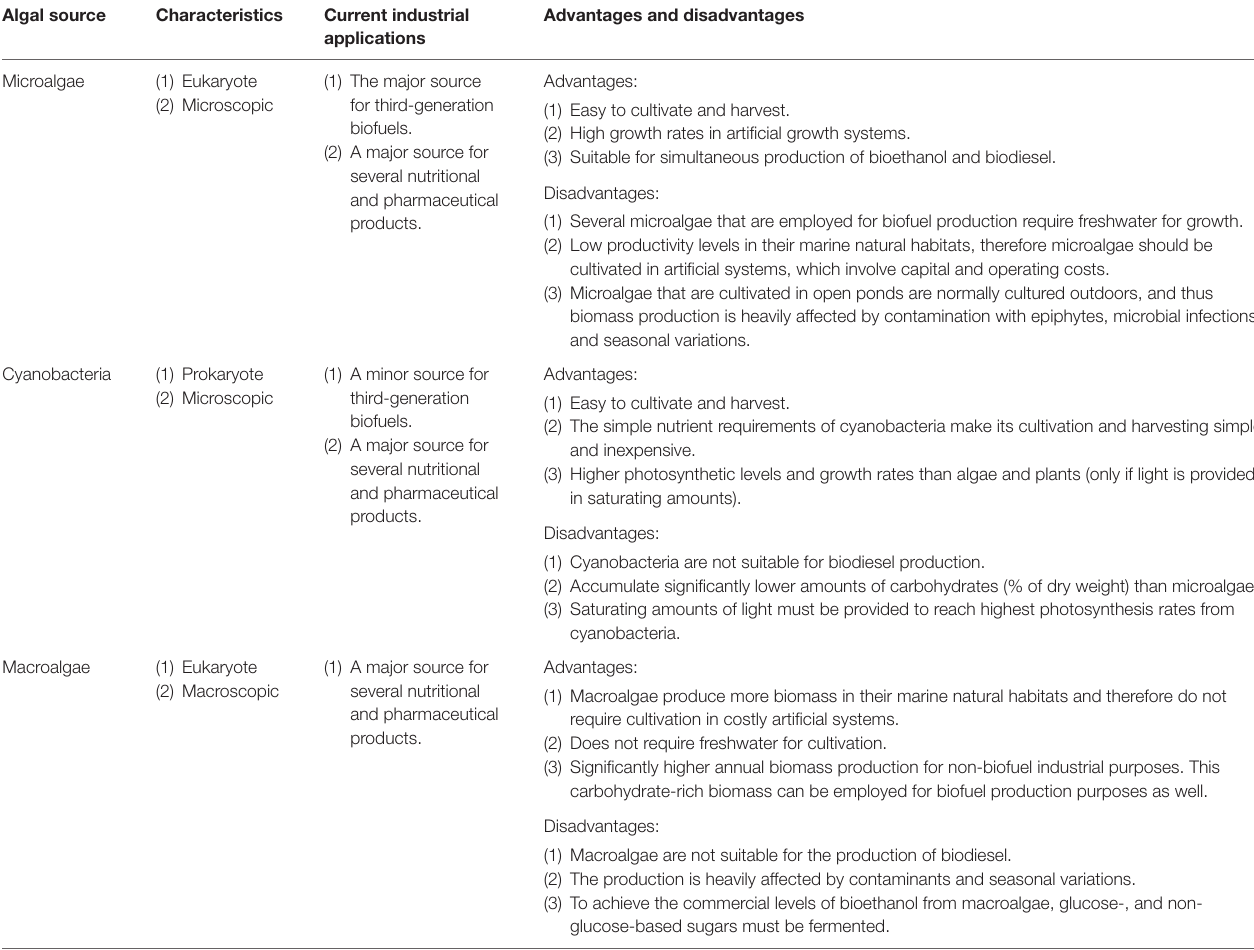
TABLe 1 | Comparison between relevant algal sources and the advantages and disadvantages of employing each for the production of third-generation biofuels. Algal source